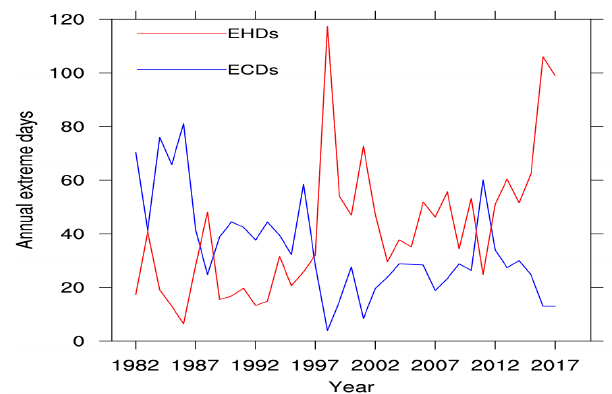
Figure 6. Regional averaged annual EHDs (red line) and ECDs (blue line) from 1982 to 2017 in the study region (units: days).